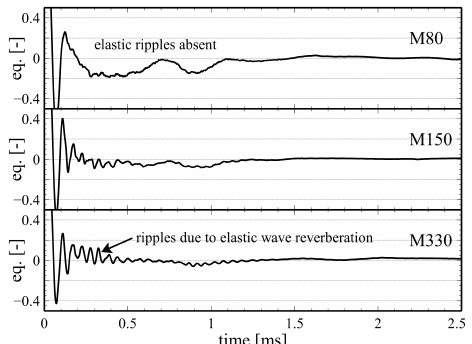
Figure 6: Evolution of dynamic equilibrium during loading at a strain rate of 500 / s.